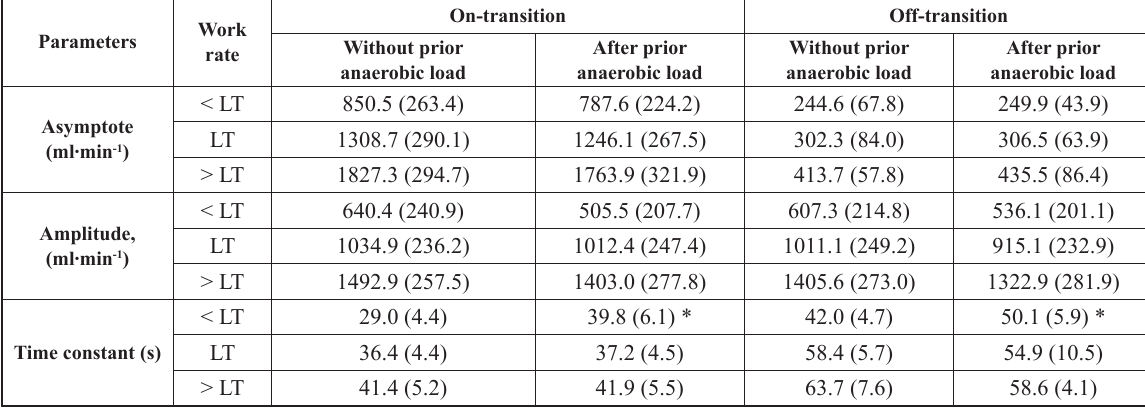
Table 2. Parameters of VCO 2 kinetics during on- and off-transition periods of intermittent increasing exercise without and after prior anaerobic load